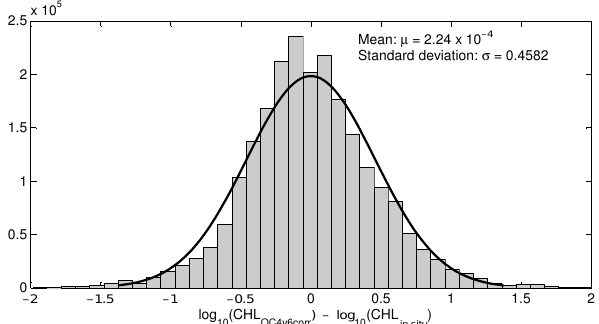
Figure 5. Histogram of the absolute error between OC4v6 corr and in situ Chl a , both in logarithmic form. Associated mean and stan- dard deviation are also shown and used to compute a relevant fitted Gaussian distribution (black